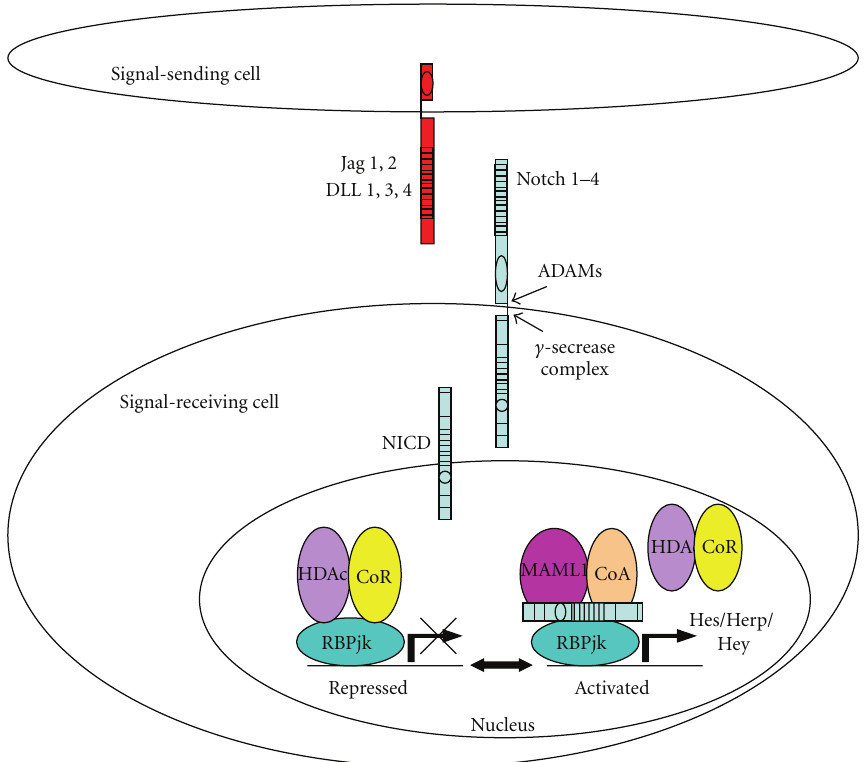
Figure 1: Mammalian cells are equipped with 4 Notch receptors (Notch1-4) and five ligands (Jag1,2 and Dll1,3,4). Notch signaling is triggered upon receptor-ligand interaction, which induces two sequential proteolytic cleavages. The first cleavage, in the extracellular domain, is catalyzed by ADAM metalloproteinases, and the second, within the membrane domain, is facilitated by the γ -secretase complex. This second cleavage allows the release and translocation of the Notch intracellular domain (NICD) to the nucleus. Binding of NICD to cotranscription factor RBPjk leads to transcriptional activation of the Notch target genes HES and HERP/HEY by displacement of a corepressor (CoR) and recruitment of the coactivator, mastermind-like protein